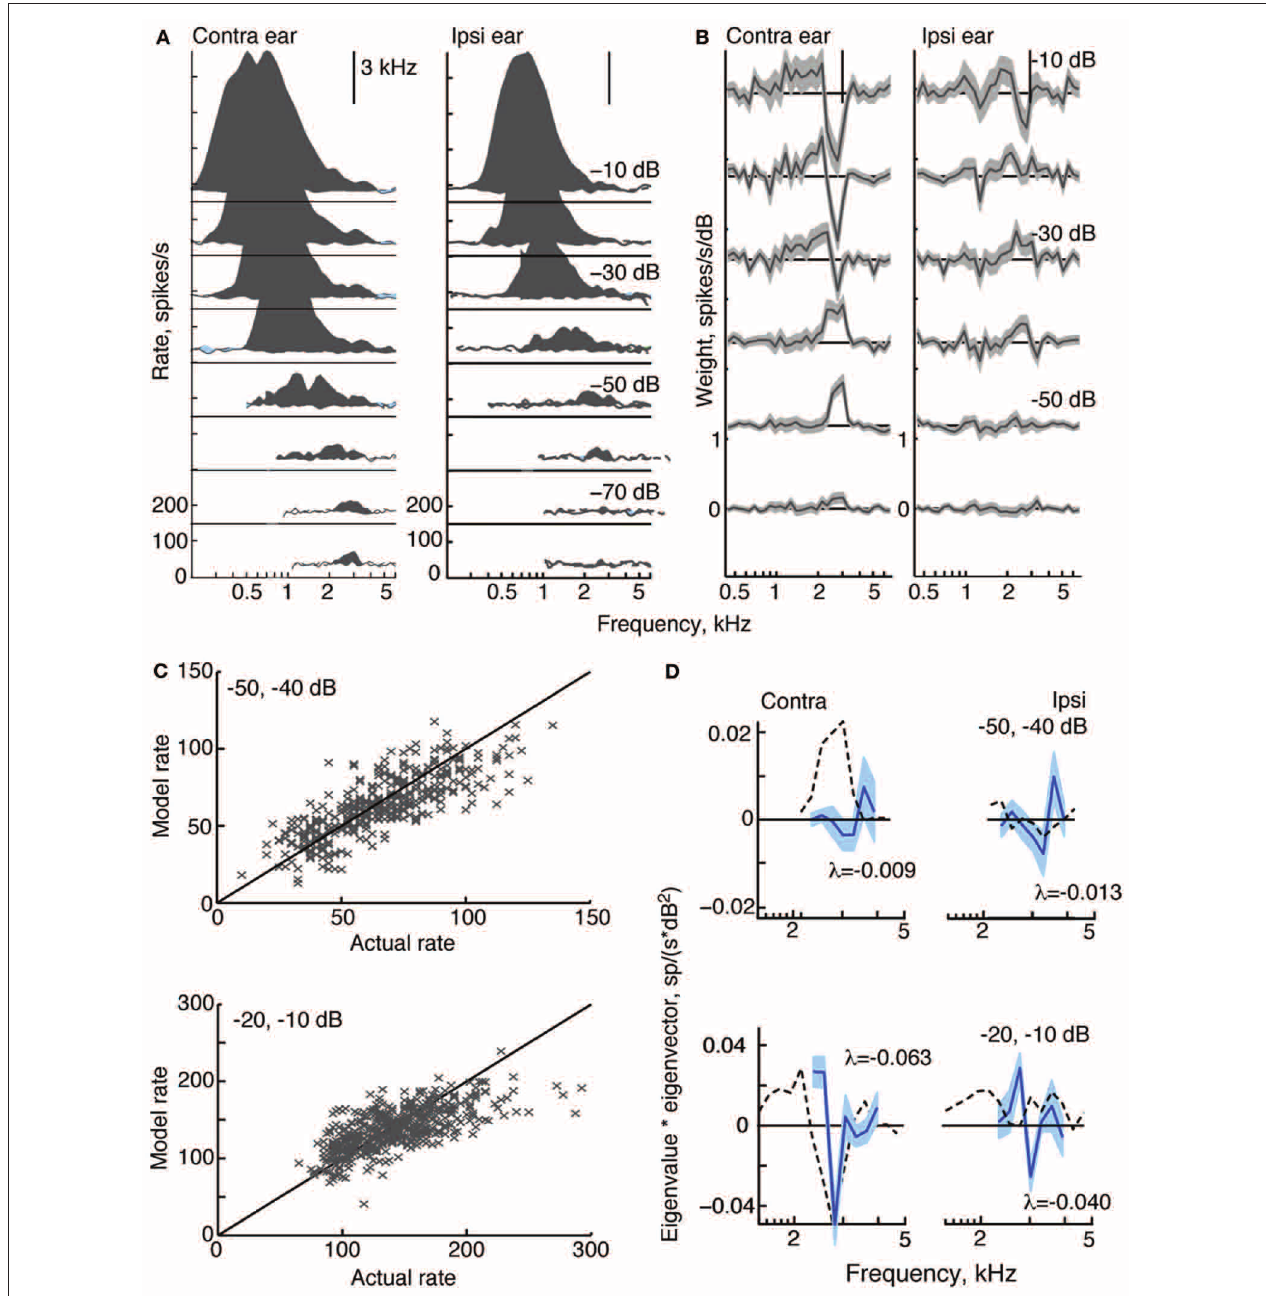
FIGURE 4 | Response characteristics for a type V neuron, BF = 3kHz. (A) Response maps, plotted as in Figure 2 . Zero dB attenuation was 98 (contra) and 95 (ipsi) dB SPL at the BF of the neuron. (B) At high sound levels, 1st-order weight functions suggest a substantial inhibitory area around